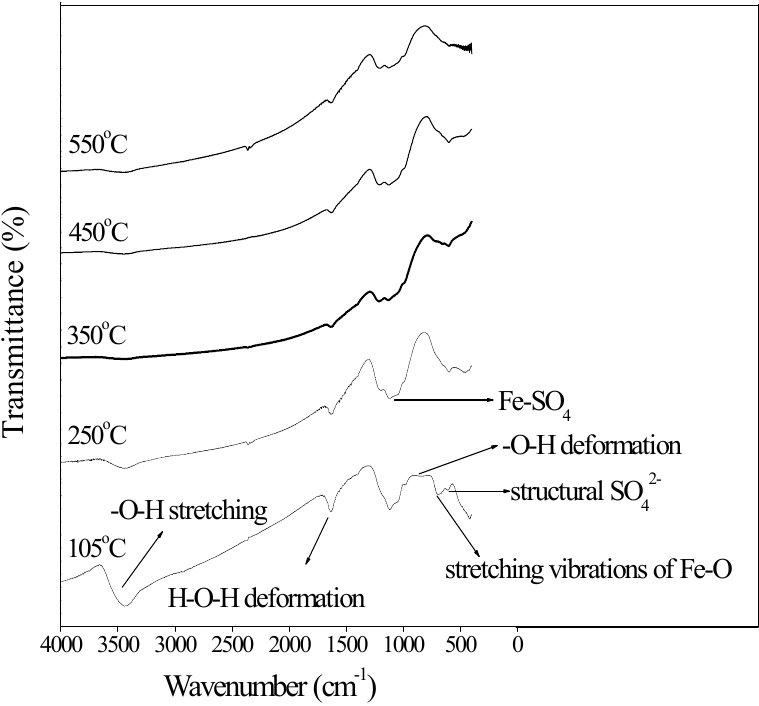
Figure 2. Fourier transform infrared (FTIR) spectroscopy of bio-schwertmannite before and after heating.